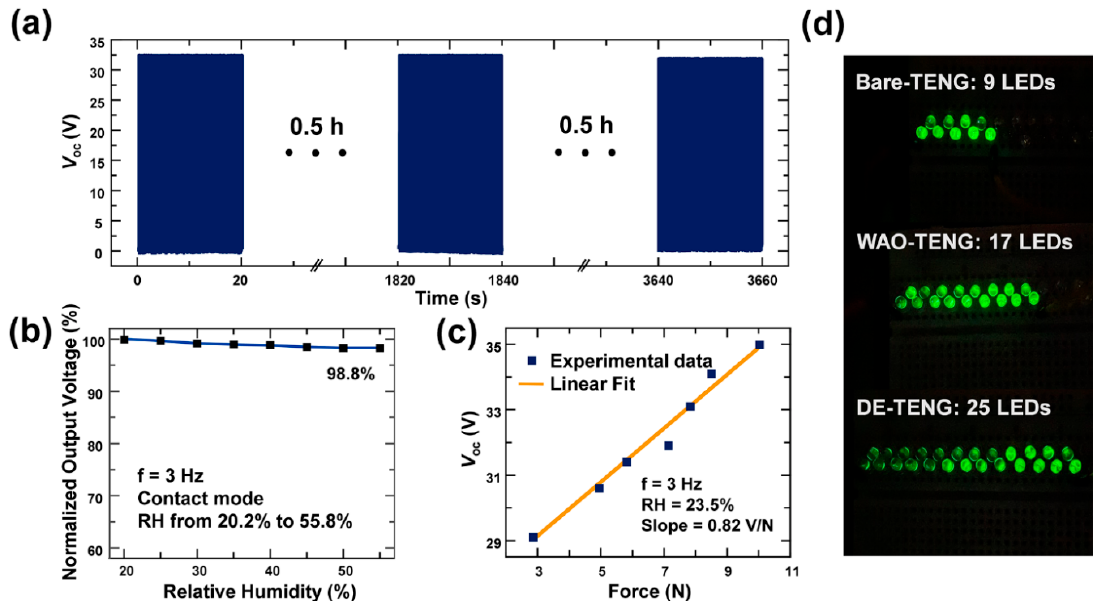
Figure 4. ( a ) The endurance test for 1 h; ( b ) stability under various relative humidity levels; ( c ) the applicability of the force sensor with a sensitivity of 0.82 V/N; ( d ) the lighting up of commercial LEDs with the power generated by the bare TENG, the WAO-TENG, and the DE-TENG.